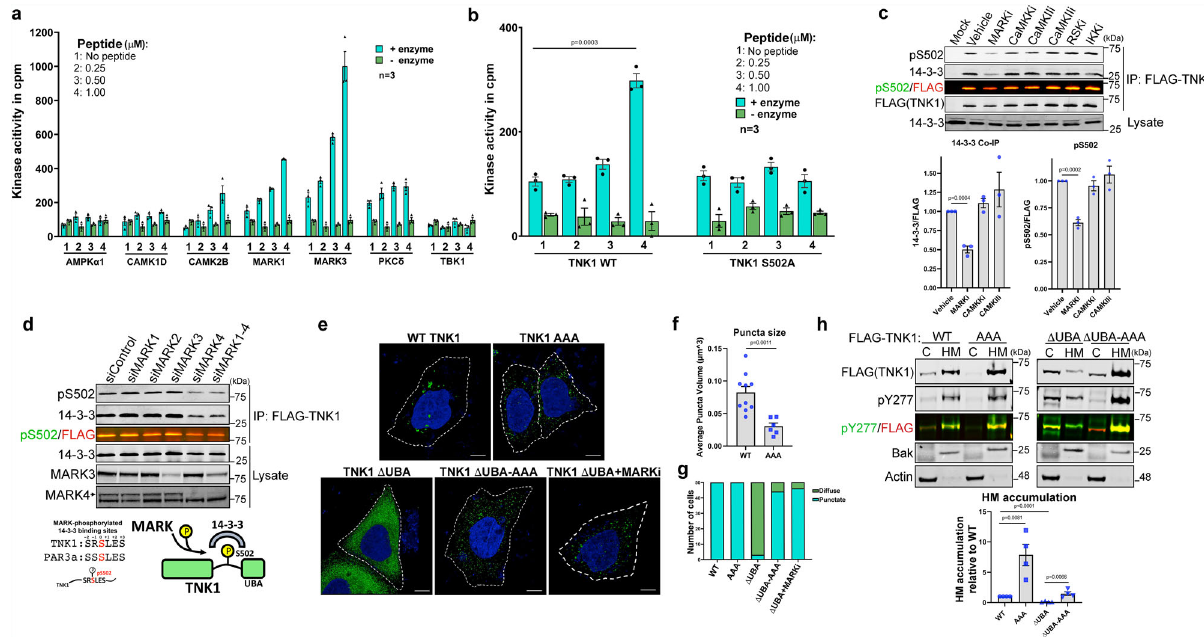
Fig. 2 MARKs mediate phosphorylation at S502 and 14-3-3 binding to TNK1, which restrains the movement of TNK1 into heavy membrane-associated clusters. a Radiometric protein kinase assays were performed to identify the kinase responsible for phosphorylation of TNK1 at S502. Corrected kinase activity (raw value minus sample peptide background) was measured in biological triplicate. Graph shows mean kinase activity in counts per minute (cpm) with error bars representing SEM. b Radiometric protein kinase assays were performed with recombinant MARK3 incubated with TNK1 WT or S502A peptides. Corrected kinase activity (raw value minus sample peptide background) was measured in biological triplicate. Graph shows mean kinase activity in counts per minute (cpm) with error bar representing SEM. P value is calculated using a two-tailed student t -test ( n = 3). c HEK293Ts expressing FLAG- TNK1 were treated with 1uM of indicated inhibitor for 4 h (MARKi: MRT 67307 dihydrochloride, CaMKKi: STO-609, CaMKIIi: KN-92, KN-93, RSKi: LJI-308, IKKi: BMS 345541). FLAG-TNK1 was immunoprecipitated and blotted for pS502 and 14-3-3. Graphs show quantitation of n = 3 biological replicates normalized to WT TNK1. Error bars represent SEM. P-values were calculated using a two-tailed student t -test. d MARK kinases were individually depleted with siRNA (100 nM) in A549 cells stably expressing FLAG-TNK1. FLAG-TNK1 was immunoprecipitated on FLAG resin and immunoblotted for pS502 and 14-3-3. Blot shows the representative image from n = 5 biological replicates. (Bottom left) Alignment of TNK1 sequence encompassing pS502 to a MARK- phosphorylated 14-3-3 binding site on PAR3a. (Bottom right) Schematic model of MARK-mediated phosphorylation of TNK1 at S502 and 14-3-3 binding. e HEK-293A cells expressing TNK1-GFP (WT or indicated mutants) were analyzed by confocal imaging for diffuse or punctate TNK1 localization and deconvolved with Hyugens software. TNK1 Δ UBA-expressing cells were treated with 1 µ M MARK inhibitor for 2 h (MRT 67307) ( n = 50). The scale bar is 10 µ m. f Cells from panel e were analyzed for TNK1 puncta volume using Leica 3D analysis software. Graph shows mean TNK1 puncta volume with error bars representing SEM between individual cells. (WT n = 10, AAA n = 6). P -value was calculated using a two-tailed student t -test. g Cells from panel e were scored for diffuse and punctate TNK1 localization as in Fig. 1b ( n = 50). h HEK-293T cells expressing WT or the indicated mutants of FLAG-TNK1 were biochemically fractionated into the cytosol and heavy membrane fractions, followed by immunoblotting for FLAG - TNK1 and TNK1 phosphorylation at Y277. Fractions were also immunoblotted for Bak and actin as loading controls. The graph shows the relative HM/C ratio normalized to WT TNK1. Quantitation is from multiple biological replicates ( n = 4) with error bars representing SEM. P -values were calculated using a two-tailed student t -test. Source data are provided as a Source Data